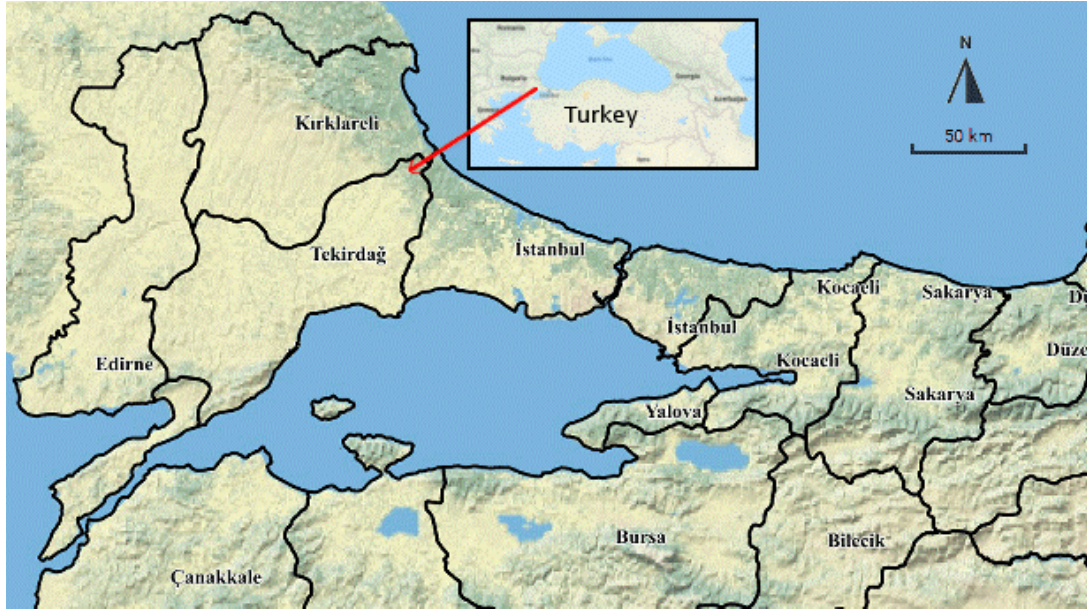
Figure 1. The study area [20].